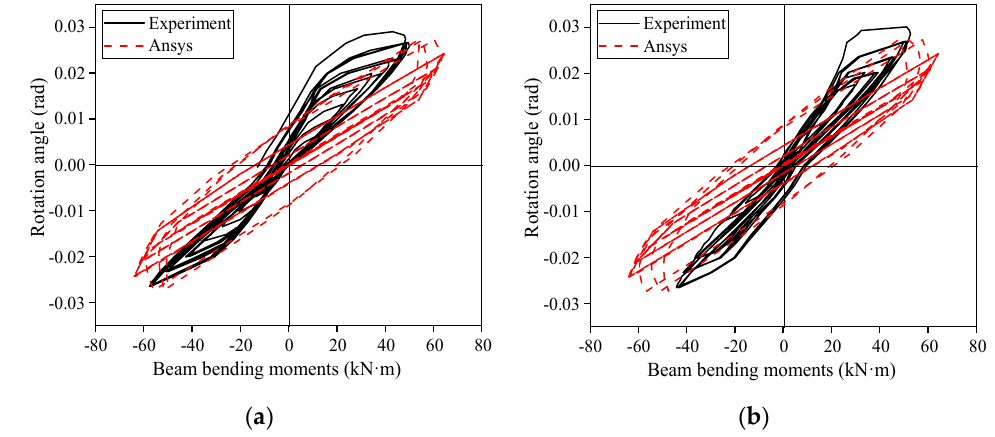
Figure 19. Comparison of joint bending moment – rotation curves. ( a ) SV2; ( b ) SV3.